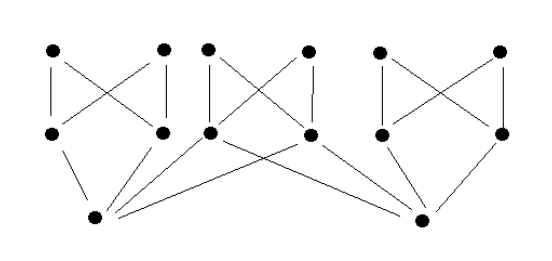
Figure 1: The finite model Y of the leaf space M 2,1 / F 2,1 .